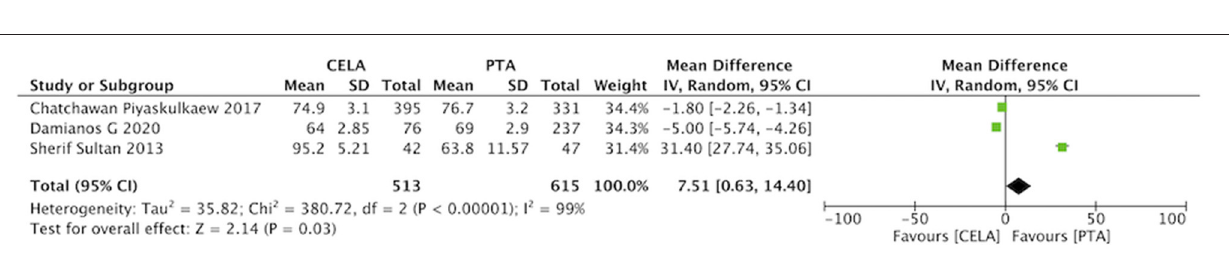
FIGURE 4 | Forest plot for 1-year patency. Random, a randomized effects model; CI, confidence intervals. The green squares stand for the weight of studies in meta-analysis. Black rhomboid represents the effects of combination of above three studies.